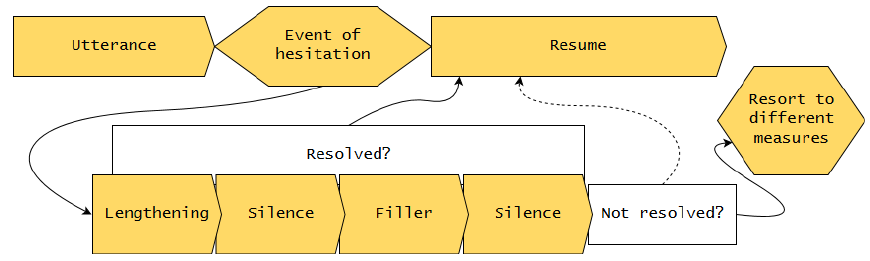
Figure 1. Hesitation insertion strategy.